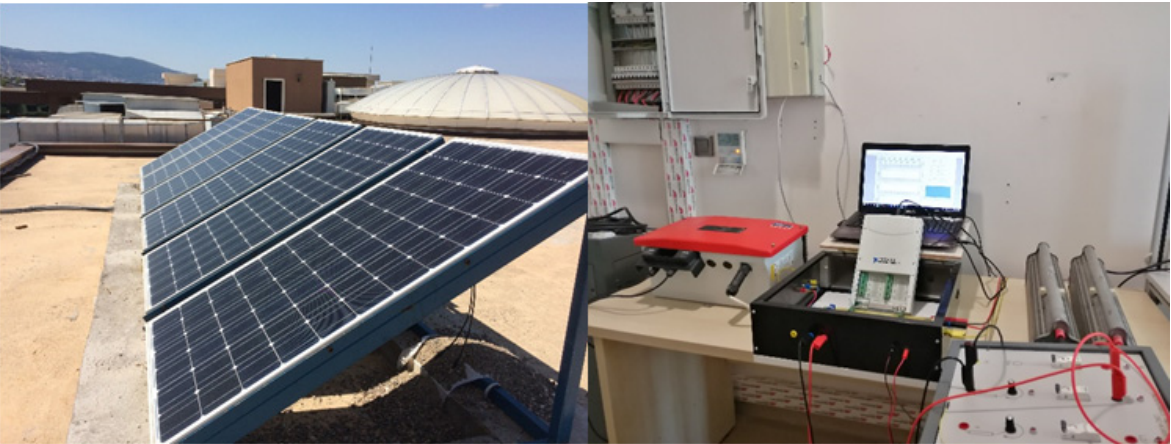
Figure 3. The developed RTEMS in the laboratory.